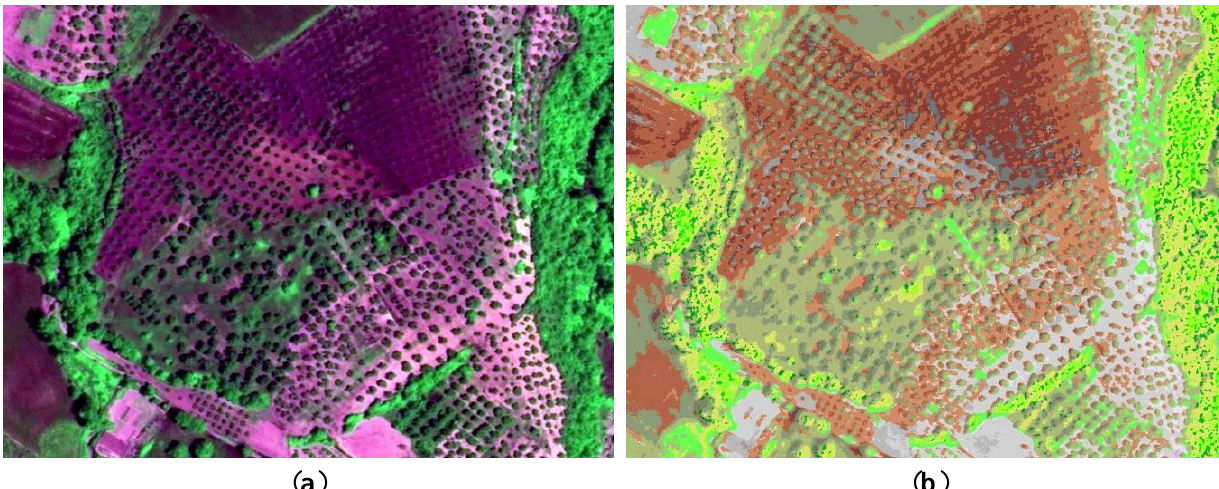
legend: refer to Table 3. The image texture information is well preserved in the preliminary classification map, e.g., the mapped forest area is high-texture while the mapped grassland is